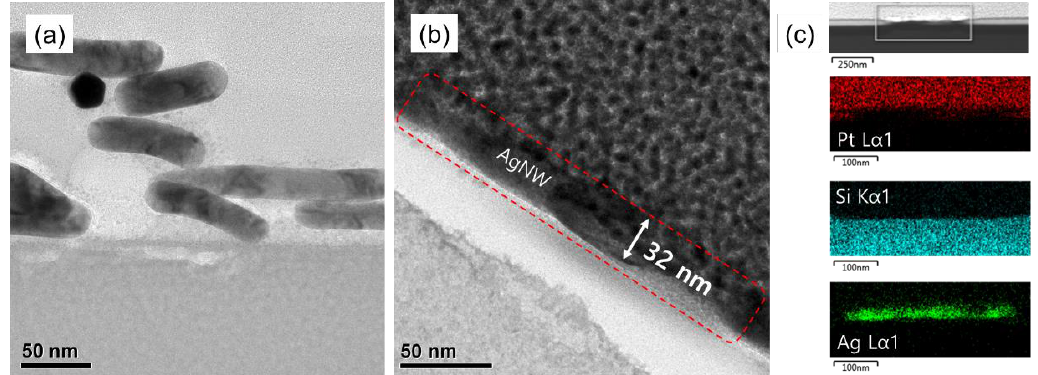
Figure 5. Cross-sectional TEM images of the AgNW network ( a ) before and ( b ) after pressurizing with 2000 N / cm 2 ; ( c ) EDX data of the Ag nanomesh on the SiO 2 substrate after pressurizing. A Pt coating was applied after the Ag nanomesh was formed on the SiO 2 surface to observe the cross-sectional TEM.